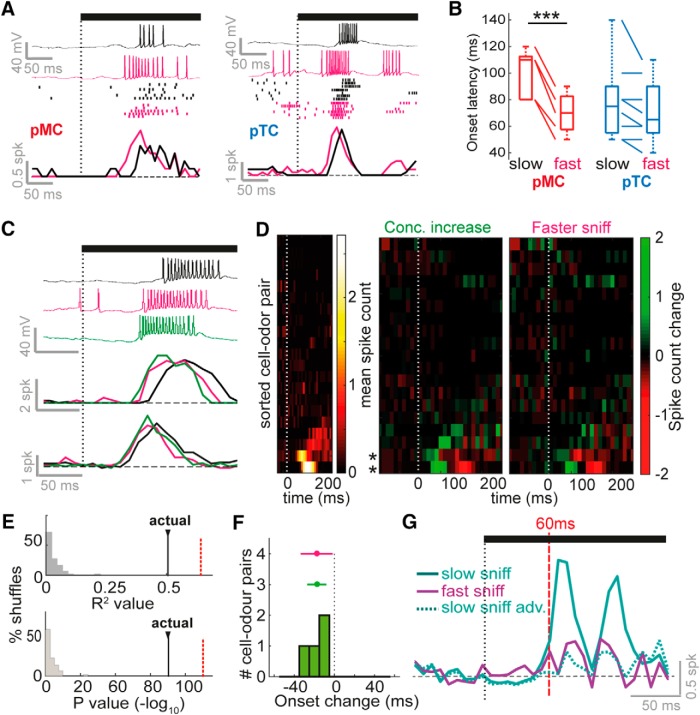
Faster inhalation causes temporal shifts similar to those caused by concentration increase. A, From top to bottom: example Vm traces, spike rasters, and mean spike counts for early excitatory responses for slow inhalation (black) and fast inhalation (pink), for two different cell-odor pairs. The left example is from a putative mitral cell (pMC) and the right example is from a putative tufted cell (pTC). Rasters are ordered (top to bottom) from slowest to fastest inhalation. Black bar and dotted line indicate odor onset aligned to the first inhalation onset. B, Comparison of response onset latencies for excitatory responses evoked by fast and slow sniffs for pMCs and pTCs. See also Fig. 2-1. C, Example Vm traces (above, for one cell) and mean spike counts (below, for two different cells) for early excitatory responses. Black shows response at low concentration evoked by slow inhalation, pink shows response at low concentration evoked by fast inhalation, and green shows response for high concentration evoked by slow inhalation. D, Left: heatmap to show spike counts of all 20 cell-odor pairs in response to low concentration odor stimulus and slow inhalation, for the first 250 ms of stimulation. Cell-odor pairs are sorted by the mean spike count during odor. Middle: heatmap to show difference in spike counts between high concentration and low concentration (evoked by slow inhalation). Left: heatmap to show difference in spike counts between fast inhalation and slow inhalation (low concentration stimulus). E, Top: R
2 values for correlations across all odor time bins as shown in D, between spike count changes due to concentration increase and due to faster inhalation. Histogram shows values for shuffle controls (see Methods), black bars show value for actual data. Red dotted line indicates value for correlation between spike count changes due to concentration increase for two separate sets of high-concentration trials. Bottom: as for above, but histogram showing p-values for the correlations (–log10). F, Histogram to show excitatory response onset latency changes due to concentration increase. Error bar in green shows mean and SD of this data, and in pink shows the distribution due to sniff changes (from dataset in panel B) for comparison. G, Euclidean distance between population spike count response vectors for high- versus low-concentration stimuli (where data for both came from slow inhalation trials; “slow sniff,” solid cyan), for high concentration and time-shifted low concentration (“slow sniff adv.,” where excitatory latency changes due to concentration change were undone via time shifting of the data; dotted cyan), and for high concentration and low concentration where low concentration data came from fast inhalation trials (“fast sniff,” solid purple).